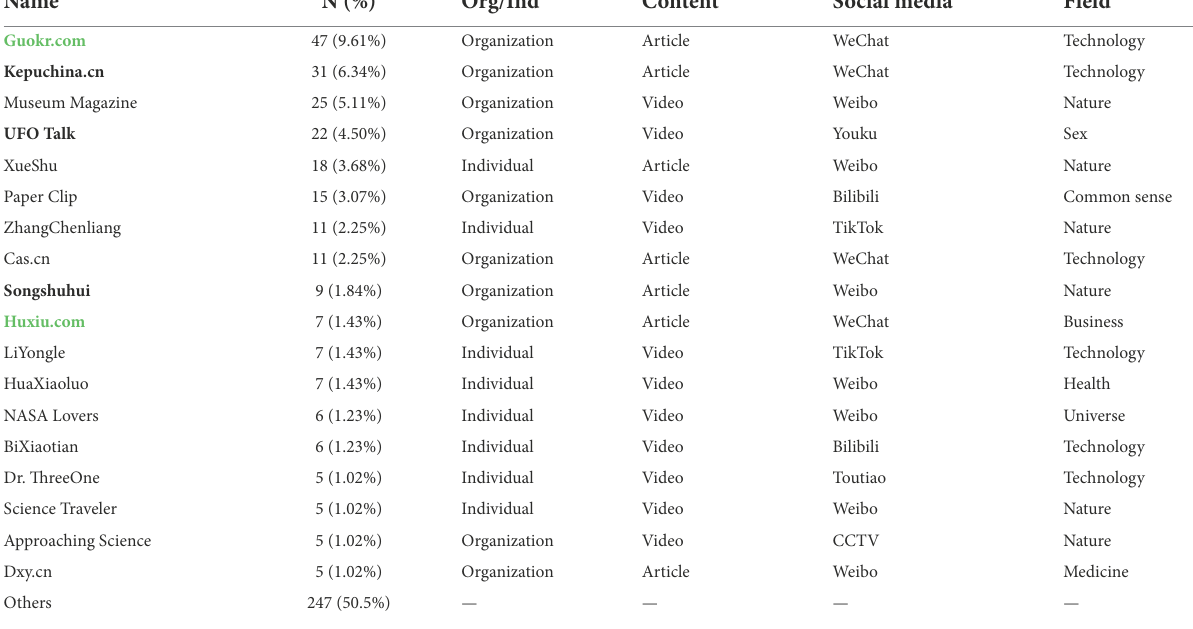
TABLE 1 Information of the communicators listed by